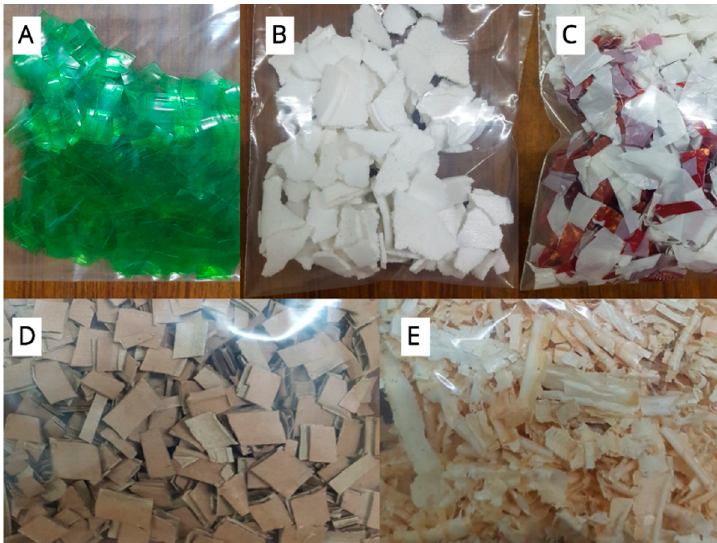
Figure 10. Photographs of carbon sources used for optimization of PHA production. ( A ) Plastic cutouts of a plastic bottle, ( B ) shredded waste polystyrene cups, ( C ) shredded plastic bag, ( D ) cardboard carton cutouts, ( E ) wood chips.